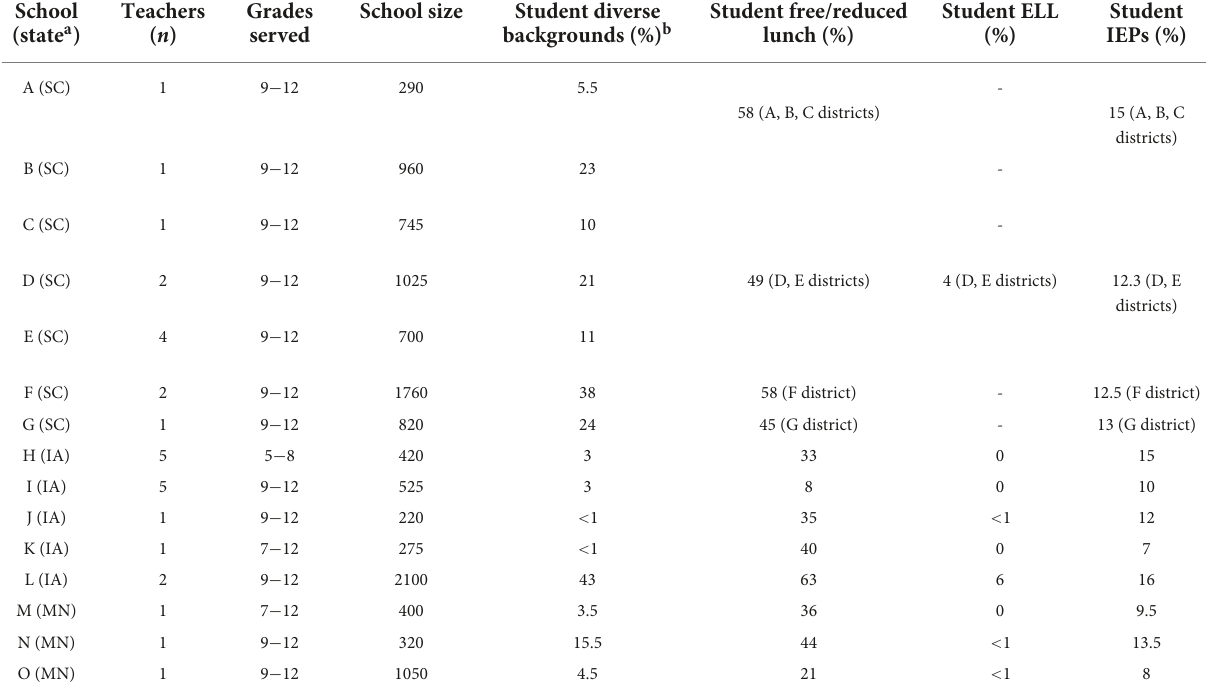
TABLE 3 Demographic information for participating schools or